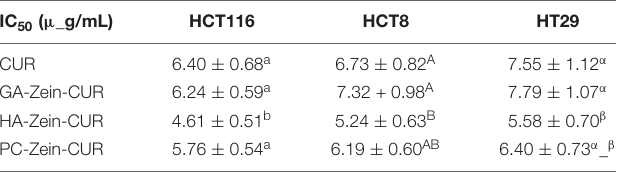
TABLE 2 | IC 50 values of CUR and PS-Zein-CUR in HCT116, HCT8, and HT29 cells. IC 50 ( µ _g/mL)